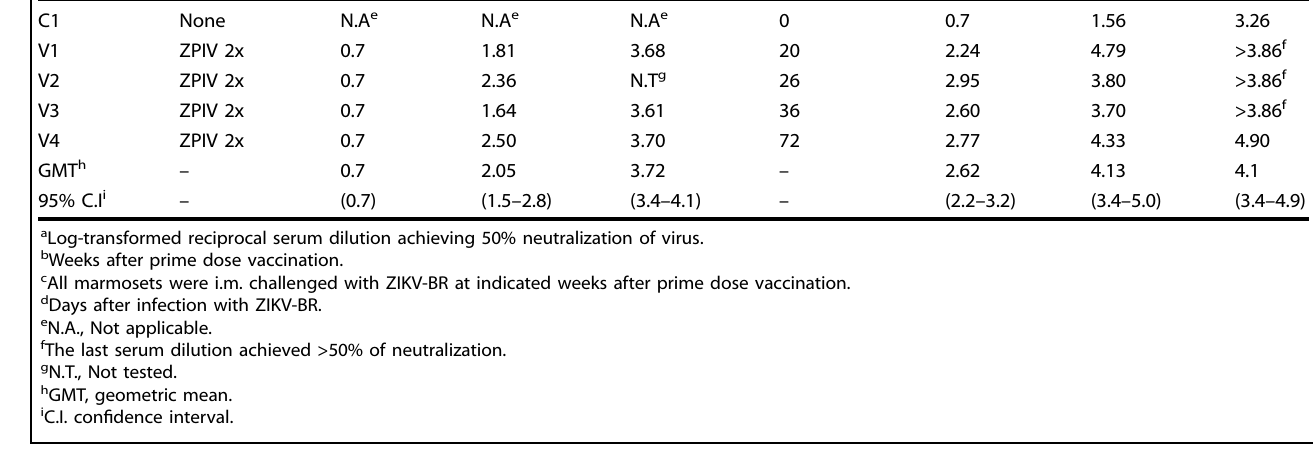
Table 2. Virus-neutralizing antibody (MN 50 ) titers in marmosets before and after ZIKV challenge a . ID